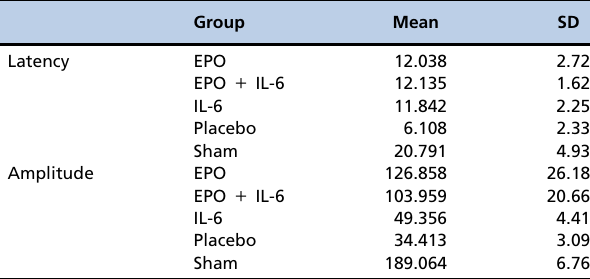
Figure 1 - Evolution of the scores on the Basso, Beattie and Bresnahan (BBB) motor scale of the five groups over the seven (2 nd , 7 th , 14 th , 21 st , 28 th , 35 th and 42 nd days) evaluation periods. The blue line indicates the results of Group EPO, the green line indicates the evolution of Group EPO + IL-6, the orange line indicates the evolution of Group IL-6, and the purple line indicates Group Placebo. The black line represents Group Sham, which did not suffer spinal cord injury (SCI) and therefore remained unchanged with respect to function. Table 2 - Motor-evoked potential (MEP) results: means and standard deviations (SDs) for latency and amplitude for the hindlimbs of the animals in each